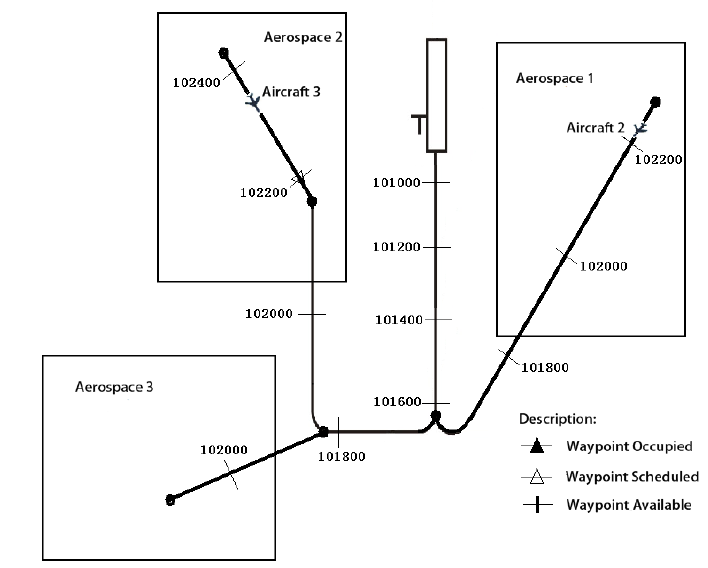
Figure 9. Team aircraft guidance in different